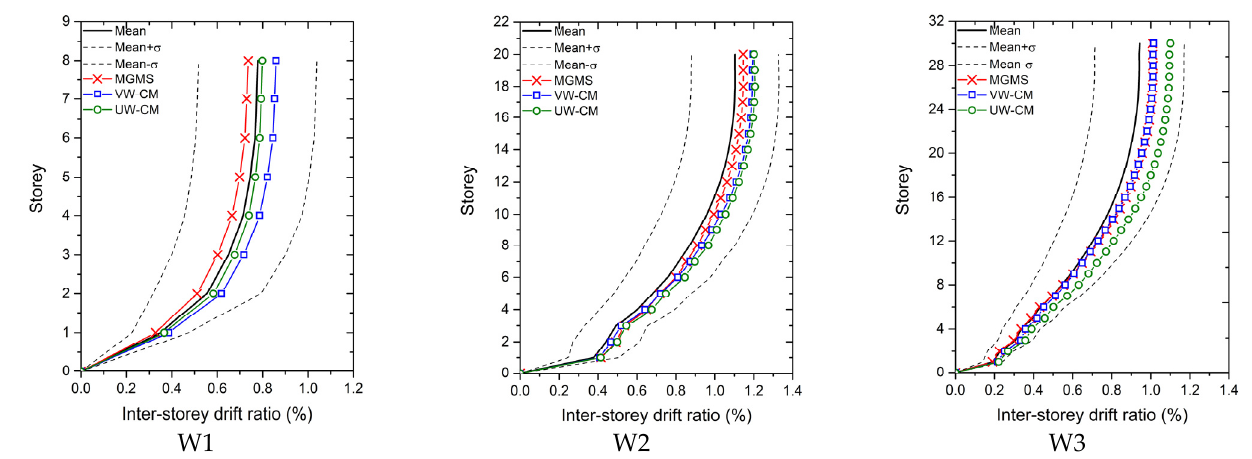
Figure 5. Comparison of the inter-story drift ratio of wall structures under motion Set 2.